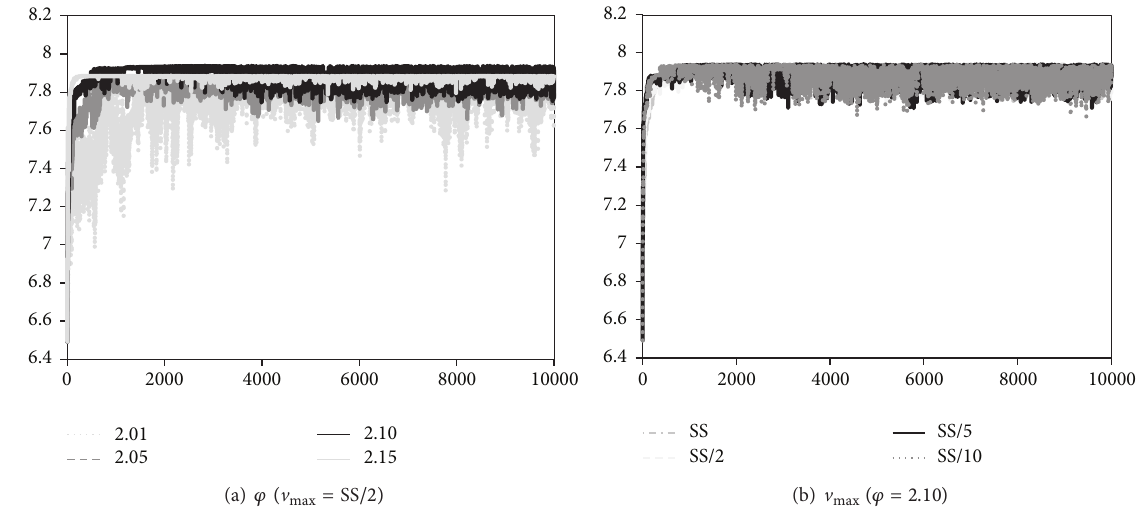
Figure 6: GA-agent tests.